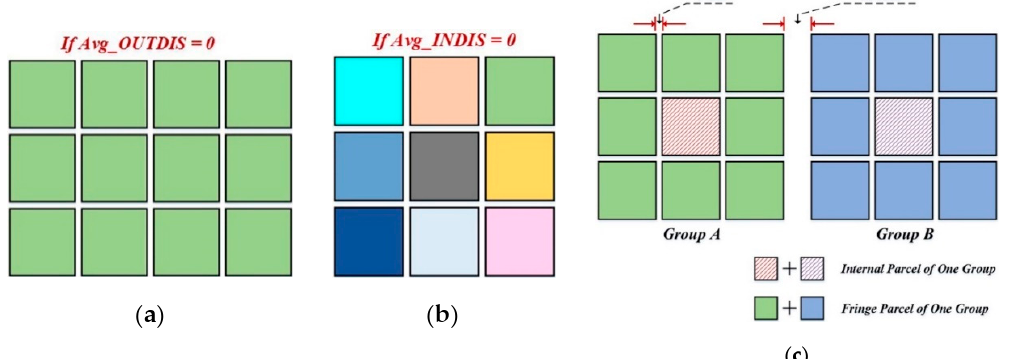
Figure 9. Illustration of three types of grouping results: ( a ) grouping result when Avg_OUTDIS is 0; ( b ) grouping result when Avg_INDIS is 0; ( c ) grouping result when Avg_OUTDIS is greater than Avg_INDIS.